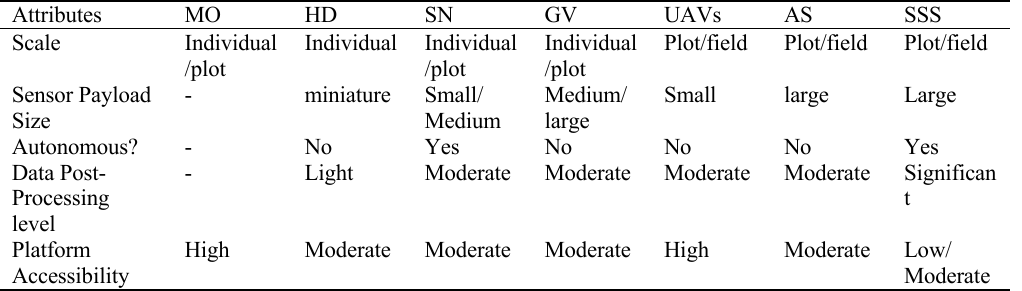
Table 1. Monitoring platforms and their attributes.